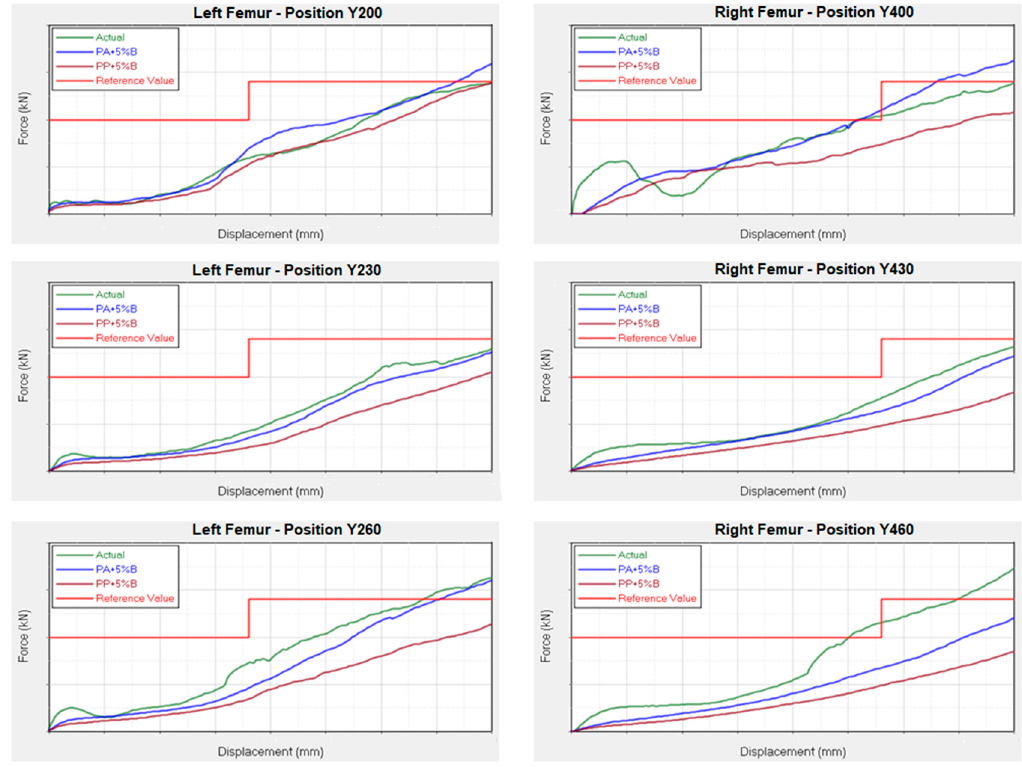
Figure 6. Results of subsystem test.